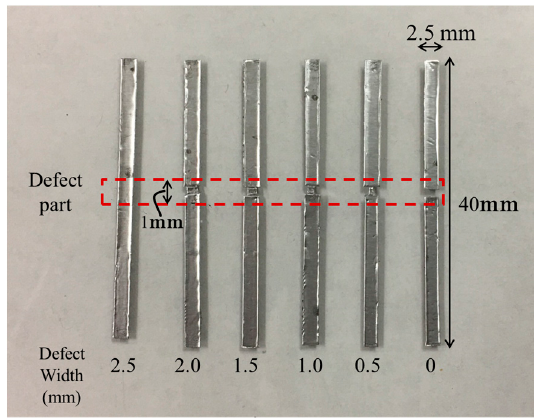
Figure 1. The optical photo of aluminum wire disconnection process reproduced sample (tilt is only for illustration).